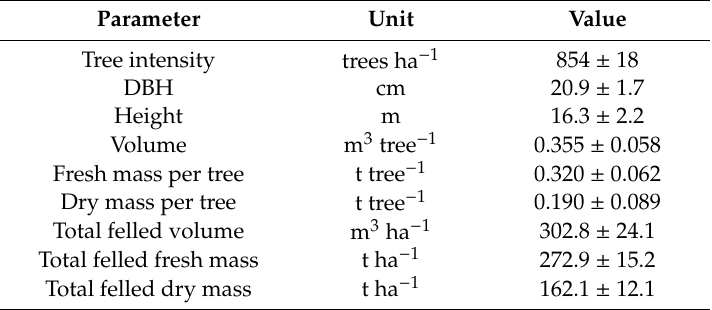
Table 3. Dendrometric parameter of the tree harvested, average results obtained from 15 trees per line. ANOVA analysis applied only on DBH and tree volume (d.f. 15, 224), p > 0.05 (average ± standard deviation).